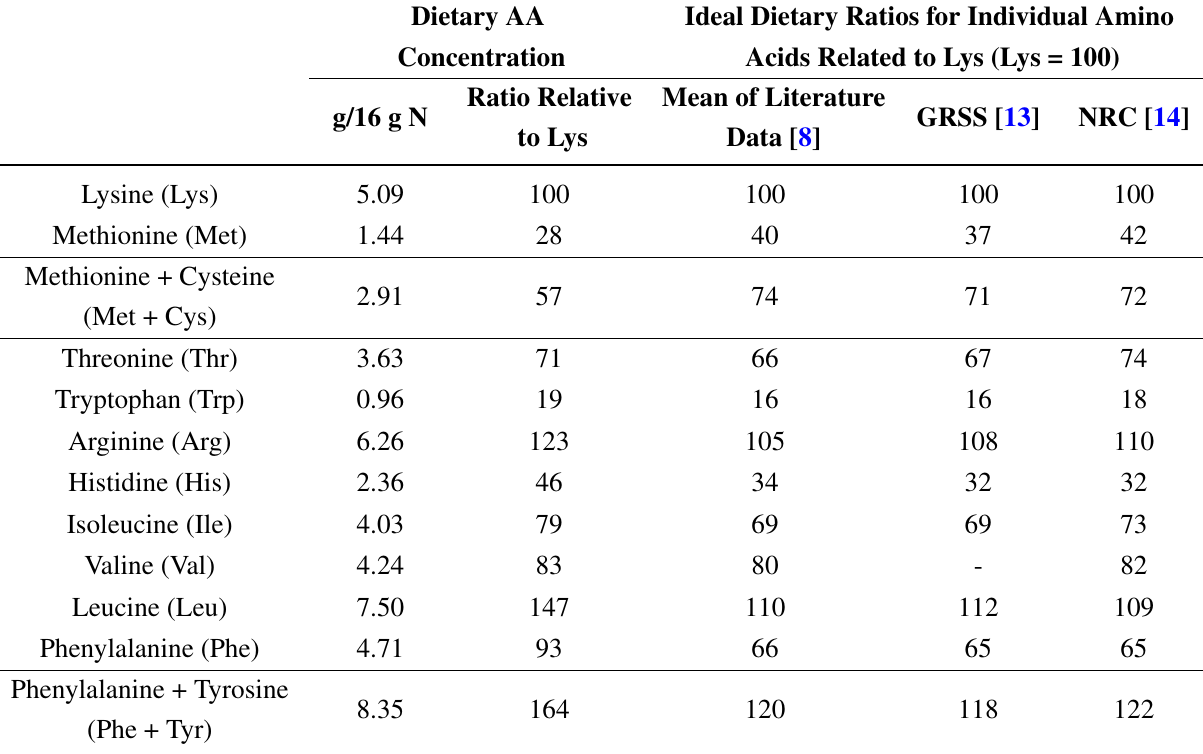
Table 2. Amino acid (AA) composition of the experimental diets and recommended ideal amino acid ratio (IAAR) in diets for growing